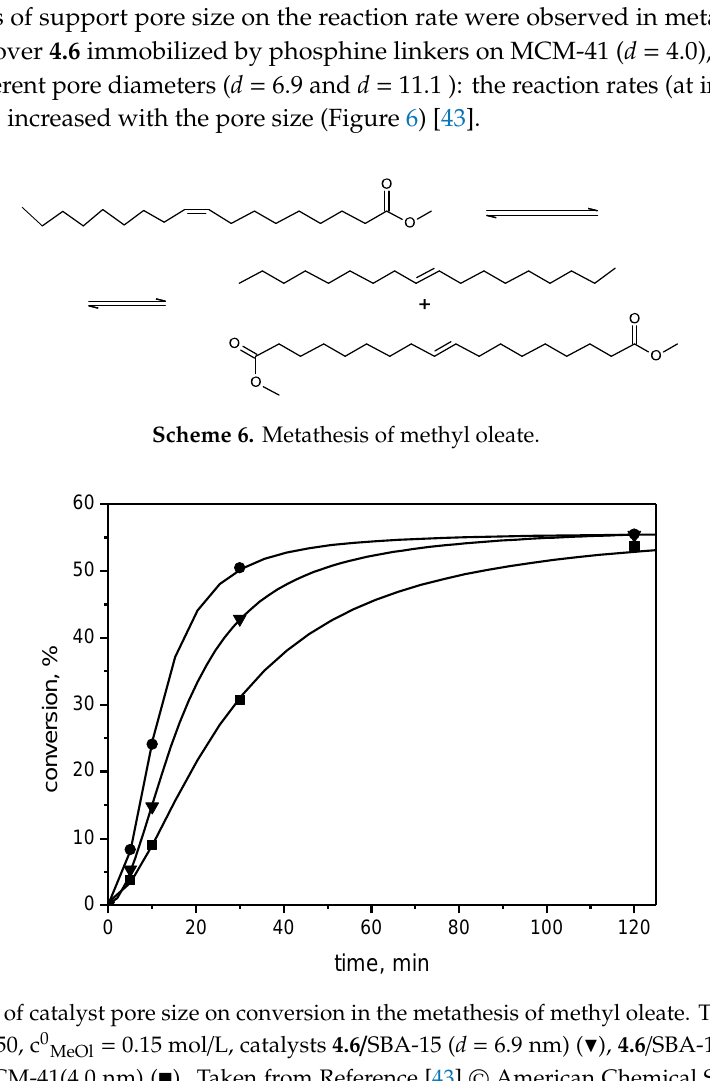
Figure 7. Self-metathesis of methyl oleate over 4.9a /SBA-15 ( ■ ), 4.9a /MCM-22 ( ▲ ), 4.9a /MCM-56 ( ▼ ), and 4.9a /MCM-36 (●). Toluene, 60 °C, molar ratio oleate/Ru = 250, c MeOl =0.15 mol/L. Taken from Reference [83]. The characteristics of the support significantly affected not only the activity but also the selectivity of the catalyst. In ADMET of 1,9-decadiene (Scheme 7) over 4.5 on MCM-41 ( d = 4.0 nm), SBA-15 ( d = 6.9), and SBA-15LP ( d = 11.1 nm) [51], the composition of oligomeric products significantly varied with the catalyst support used. When increasing the pore diameter, the selectivity to dimer decreased, and the selectivity to higher oligomer increased. In ring-opening/ring-closing metathesis of cyclooctene (Scheme 8) over 4.4 linker-free immobilized on various supports, the catalysts on SBA-15 and MCM-41were the most active. However, they strongly differed in selectivity.